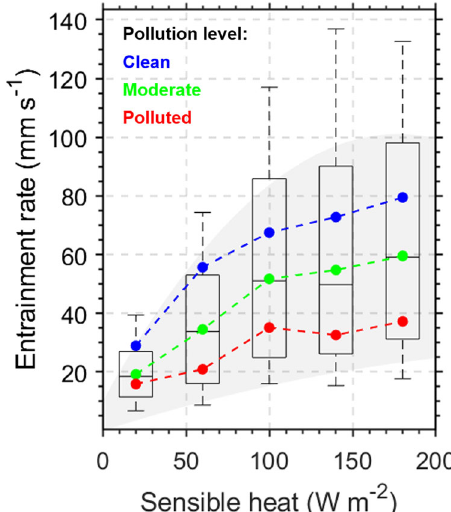
Fig. 2 Entrainment rates for different pollution levels. Observed distribution of entrainment rate as a function of sensible heat fl uxes. Box-and-whisker plots show the percentile values of 10 th , 25 th , 50 th , 75 th , and 90 th . Blue, green, and red dots represent the mean values of PBL entrainment rates under clean (percentile: 0 – 33%), moderate (percentile: 33 – 67%), and polluted conditions (percentile: 67 – 100%), respectively. Hereafter, low cloud cases are excluded to avoid heat fl uxes induced by boundary-layer